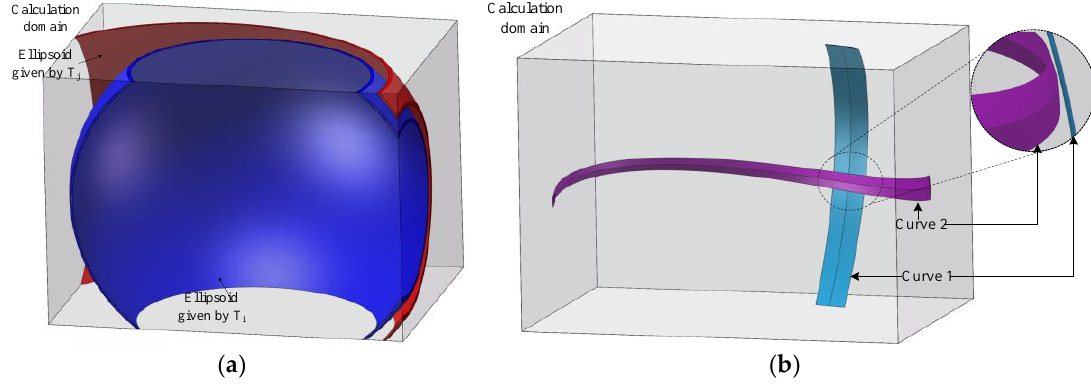
Figure 5. ( a ) The disjoint ellipsoids. ( b ) The disjoint curves.